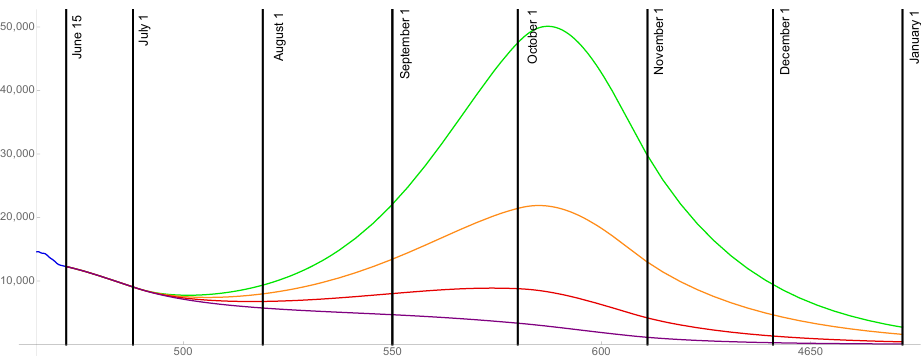
Figure 9. Model outcomes for the daily reported cases DR ( t ) , for the level of social distancing resumption ω = 0.03 (green), ω = 0.025 (orange), ω = 0.02 (red), ω = 0.015